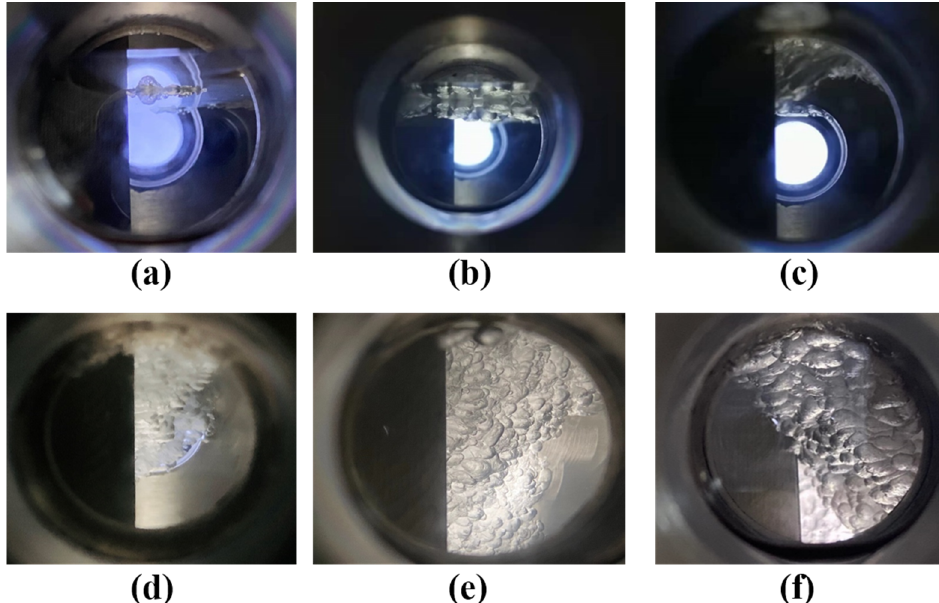
Figure 18. Image recording through the external windows that hydrate the bubbles floating at the gas–liquid interface and their accumulation process at ( a ) 20 h, ( b ) 24 h, ( c ) 64 h, ( d ) 97 h, ( e ) 120 h, and ( f ) 145